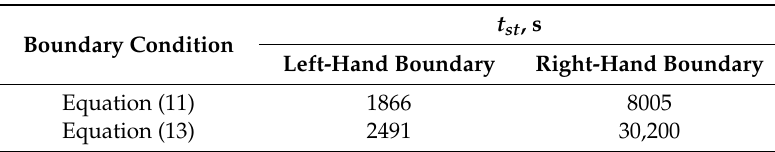
Table A1. The computation time, t st , needed when using boundary Condition (11) or (13) at the left-hand ( x = 0) or right-hand ( x = 1) boundary. t st , s Boundary Condition Left-Hand Boundary Right-Hand Boundary Equation (11) 1866 2491